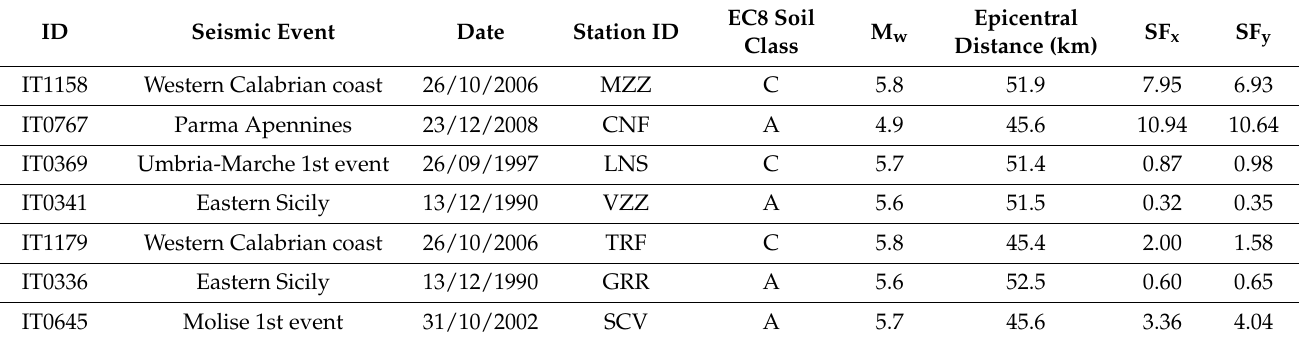
Table 5. Characteristics of the real accelerograms selected for a 30-year return period of the seismic action. M w is the moment magnitude and SF is the scale factor applied to obtain spectrum compatibility.